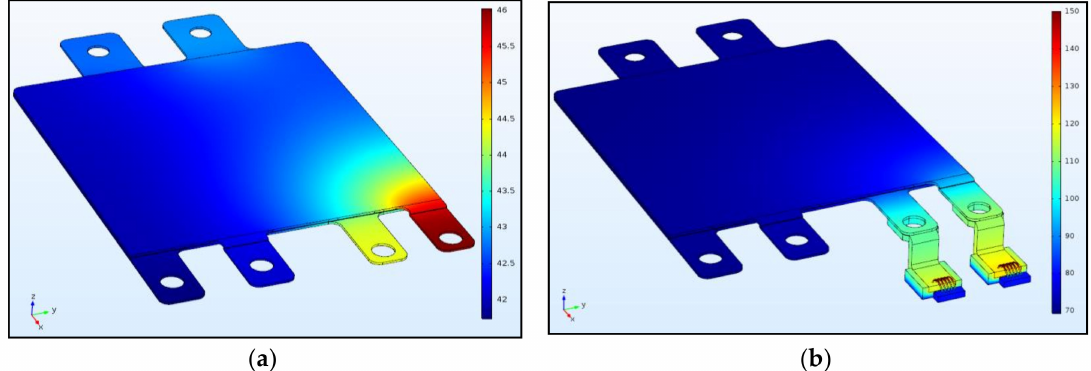
Figure 6. Temperature at the surface of the busbar (in ◦ C): ( a ) Without taking into account the thermal interaction with the power module; ( b ) Taking into account the power terminals of module